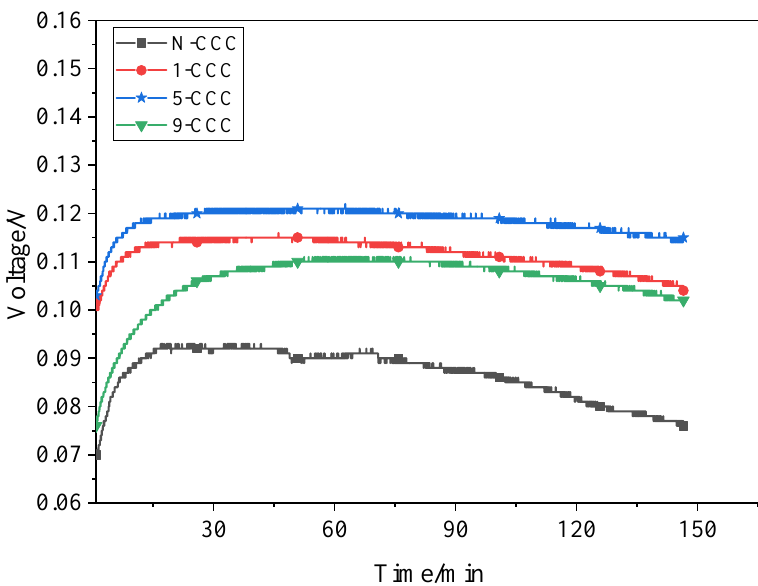
Figure 14. EIS of µ DMFC with different gradient wettability CCC after